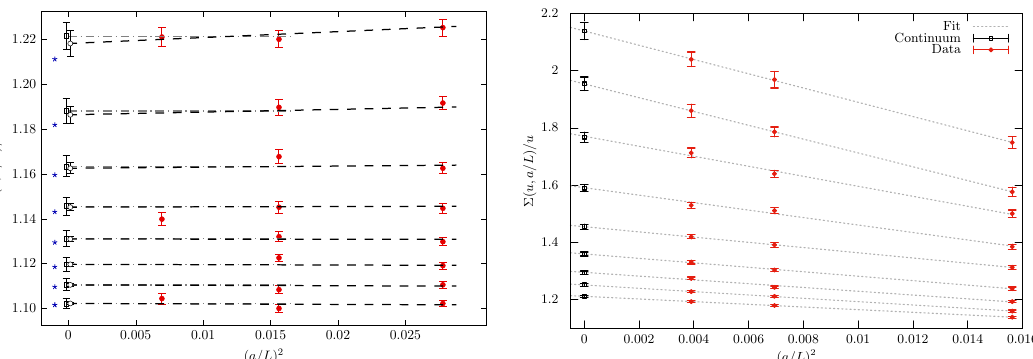
Figure 2. Continuum extrapolations of the lattice SSF of ¯ g 2 for different values of the couplings. The lattice data is shown in red while the black points are the continuum extrapolated results. For the details on the extrapolations, we refer to [7] and [5], respectively.